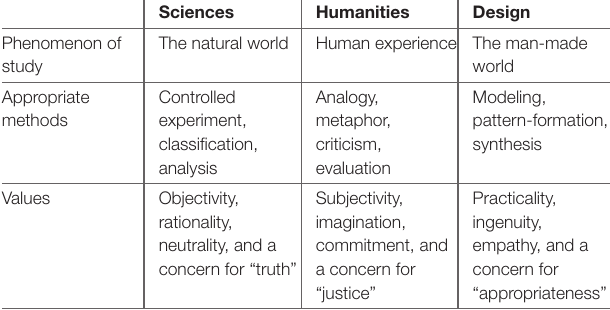
TABLE 1 | A table based on the work of Cross (1982) roughly defining the differences between each of the disciplines, and setting design as its own